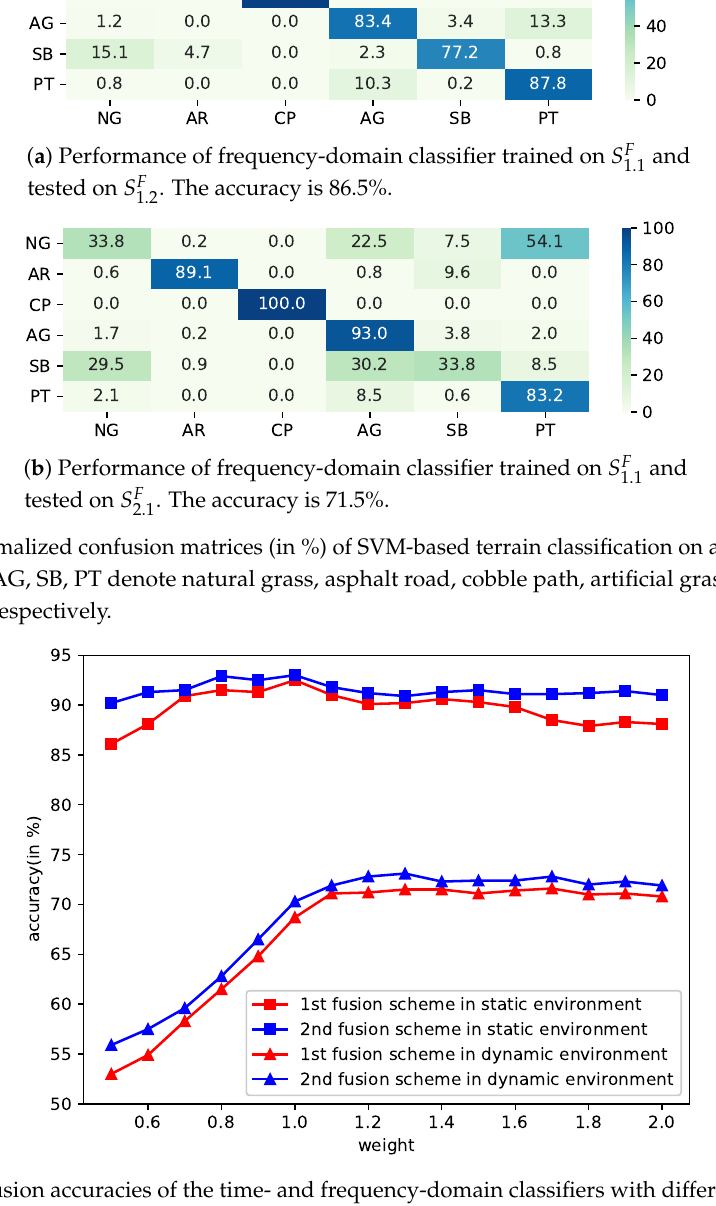
Figure 7. Fusion accuracies of the time- and frequency-domain classifiers with different